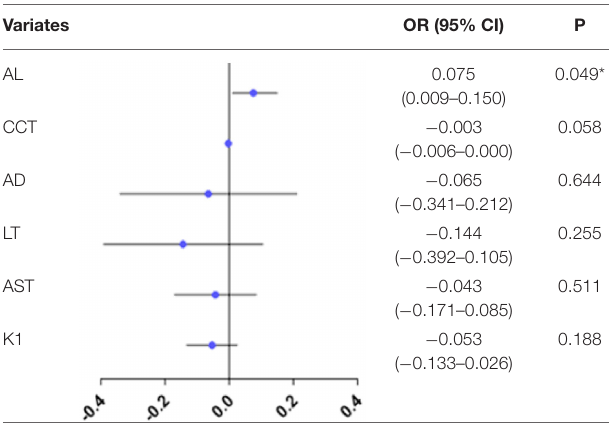
TABLE 5 | Relationship between RPRE and ocular biological parameters at 30–35 ◦ eccentricity.